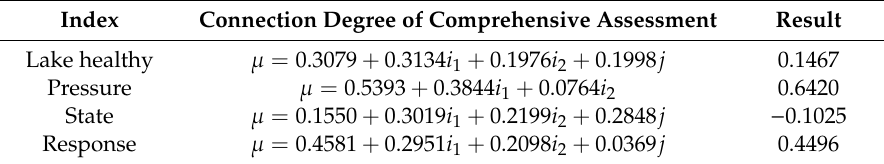
Table 5. Expression of the connection degree of the total index and the